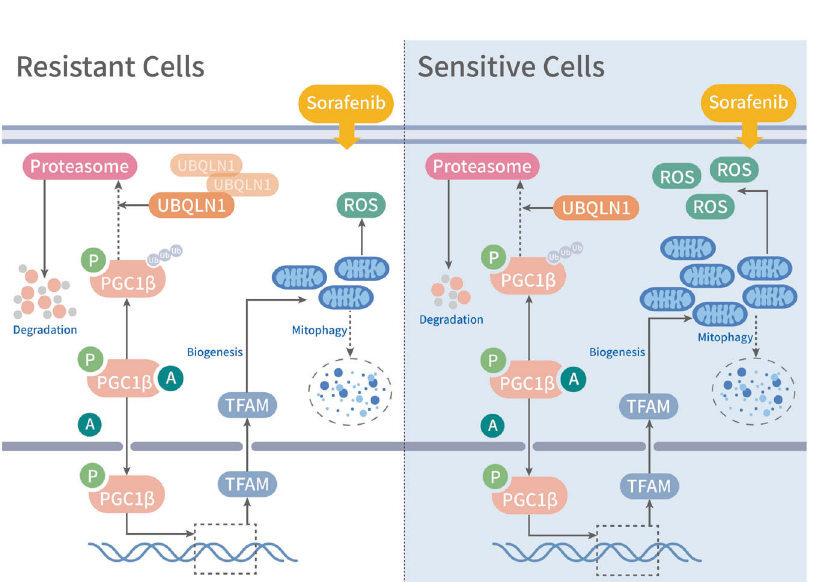
Fig. 6 Proposed mechanistic depiction of sorafenib resistance. The alleviated ROS responses in sorafenib-resistant HCC cells was due to decreased mitochondrial biogenesis. Mechanistic dissection indicated that upregulation of UBQLN1 in sorafenib-resistant HCC cells accelerated the protein degradation of PGC1 β , contributing to the decreased mitochondrial biogenesis and ROS generation, fi nally inducing sorafenib